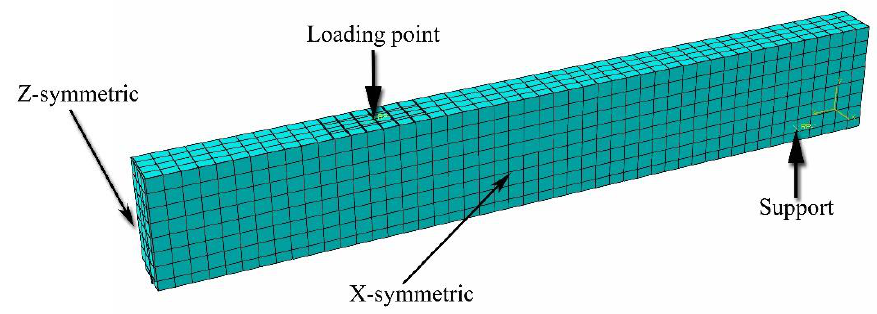
Figure 14. Finite element mesh of simulated beam (one quarter).